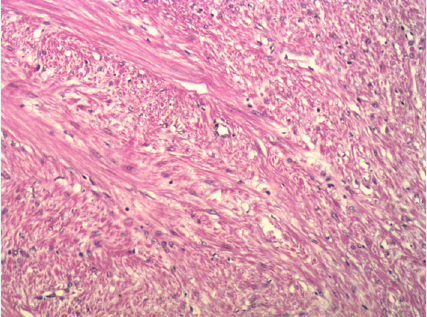
Figure 2: The pathological image of the bladder